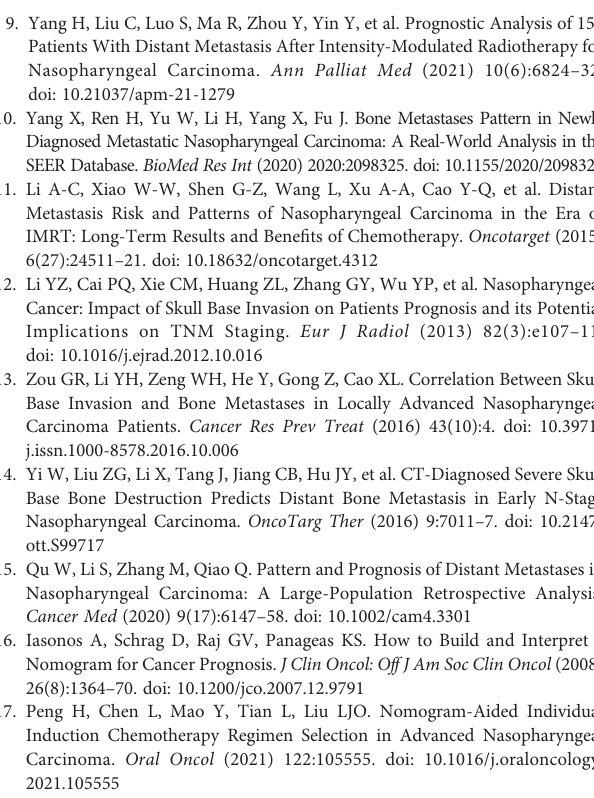
Supplementary Table 2 | Collinearity analysis of skull base invasion and